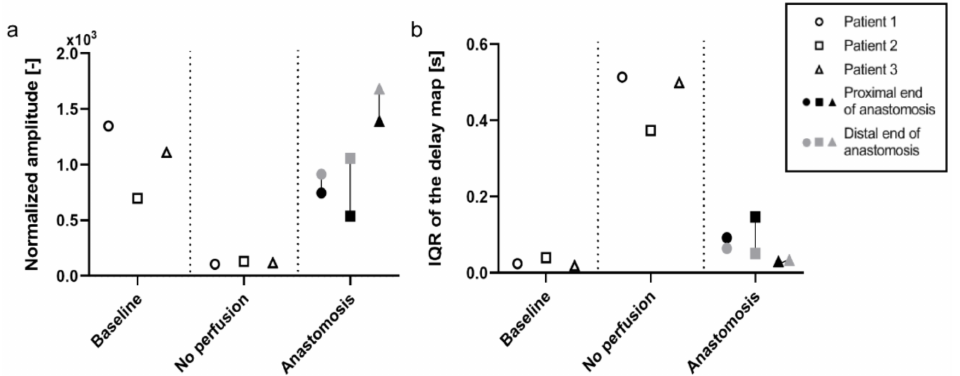
Figure 5. Graphs displaying iPPG trends of the amplitude and delay maps in different states of perfusion during surgery ( n = 3). For the PPG amplitude maps the median value is used, whereas for the PPG delay maps the inter-quartile range (IQR) is used. ( a ) The median amplitude of the iPPG signal seems to be closely related to the perfusion state of the tissue, ( b ) whereas the IQR of the delay map seems to be inversely related to the perfusion of tissue. In the anastomosis condition, the reconnected bowel ends which form the anastomosis, proximal (black) and distal (grey), seem to be perfused